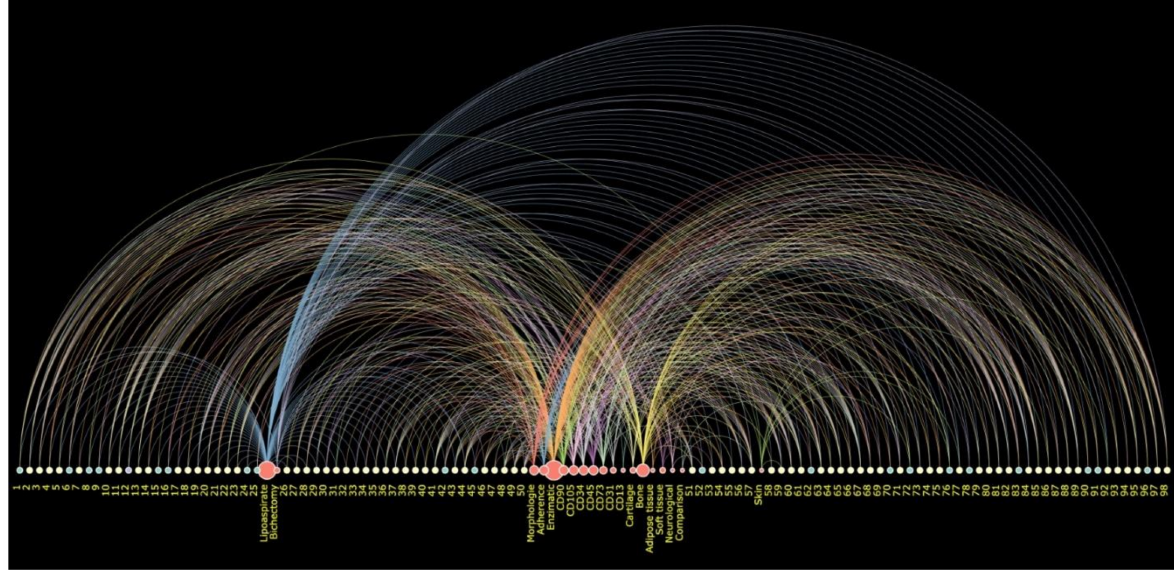
Figure 12. Interactive arc diagram (on, mouse hover; out) https://arc-diagram-gep.tiiny.site/ (accessed on 29 June 2021). The standard small-sized yellow/cian//lilac nodes represent each of the 98 articles (1–98 numbers on diagram). Using on-mouse hover, the yellow nodes/arcs show the articles with 50–60% positive sign from authors in answering the required protocol questions. The green nodes/arcs represent the articles with a positive sign in 70% or more questions. The lilac node/arc represents the article which contained less than 50% positive sign from questions of the protocols required according to the quality standard assessed in this review. The red nodes (different sizes) represent the origin (liposuction/bichectomy), the main characterization and differentiation analyses and, finally, the clinical application (bone, cartilage, skin, adipose tissue, soft tissue, neurological or origin cell comparison) used individually. The size of the red nodes represents the quantity of articles presenting such analyses (on, mouse hover). By hovering the mouse over each analysis (red node), the reader can visualize the breadth of the quantity of articles (quantity of lines) that was accomplished in each protocol